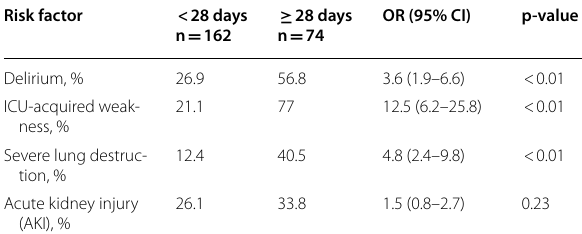
Table 2. Potential modifiable risk factors contributing to ICU